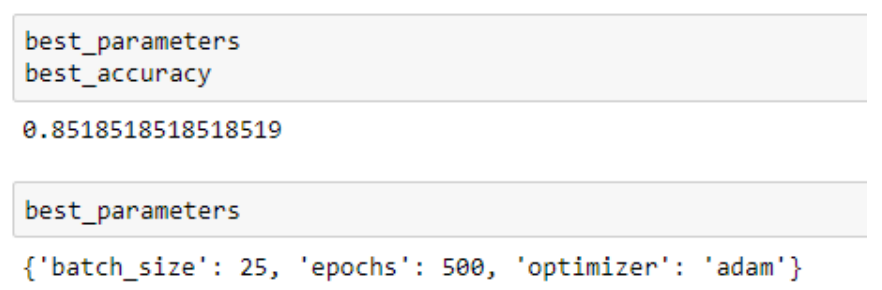
Figure 39. The accuracies achieved by the Folds after performing 10-Fold Cross-Validation on the ANN (3-20-20-1) model.